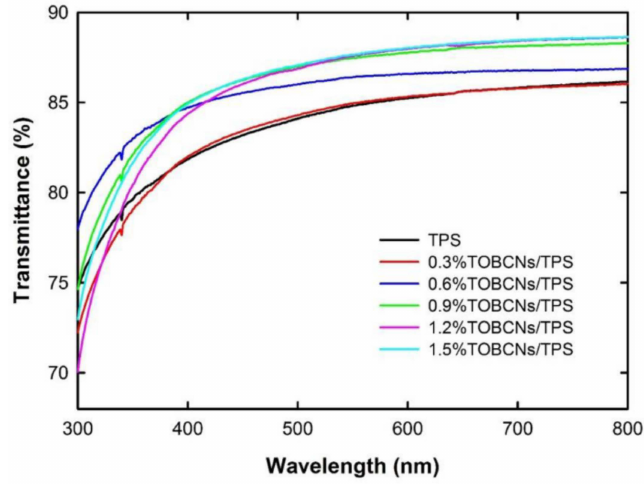
Figure 16. Light transmittance spectra of TOBCNs/TPS nanocomposite films. Reproduced with permission from BioResources , 14 , Pitiphatharaworachot et al., Starch nanocomposites reinforced with TEMPO-oxidized cellulose nanofibrils derived from bamboo holocellulose, 2784–2797, 2019 [81].